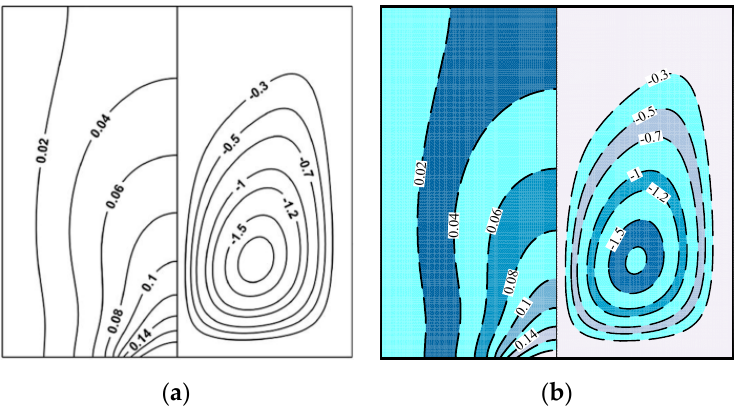
Figure 3. The motion and temperature patterns from ( a ) Gibanov et al. [26] and ( b ) current study for 𝑅𝑎 = 10 (cid:2873) , 𝐻𝑎 = 10 , 𝑀𝑛 (cid:3033) = 0.0 , 𝜙 = 0.04 , and 𝑃𝑟 = 6.2 .